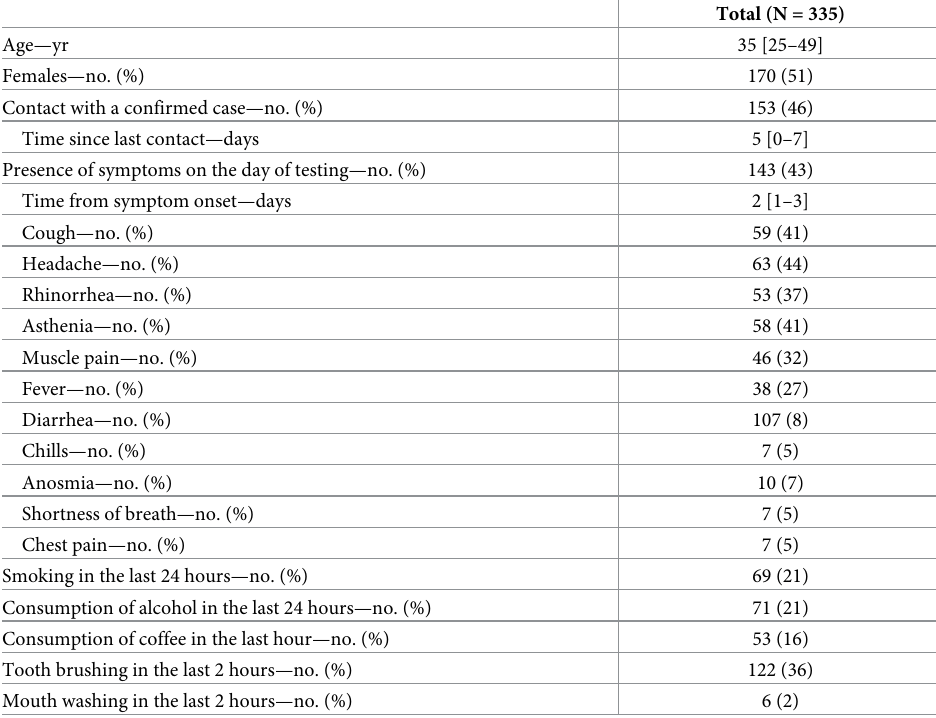
Table 1. Characteristics of study participants. Results are presented as N (%) or medians [interquartile ranges].